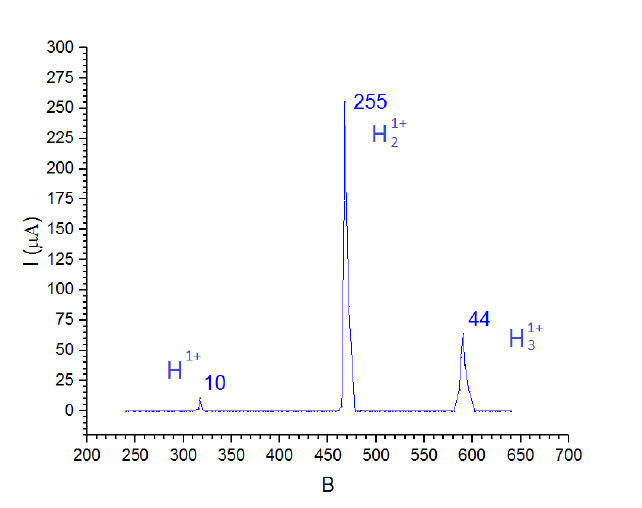
Fig. 6. Spectrum of hydrogen ions at 2450 MHz, 60 W and Ø2 mm extraction